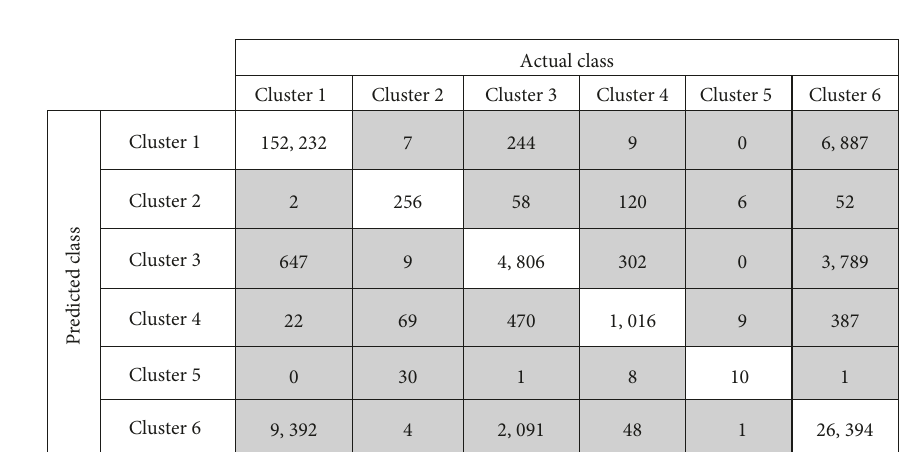
Figure 5: Confusion matrix table of random forest model. Table 15: Confusion matrix of random forest